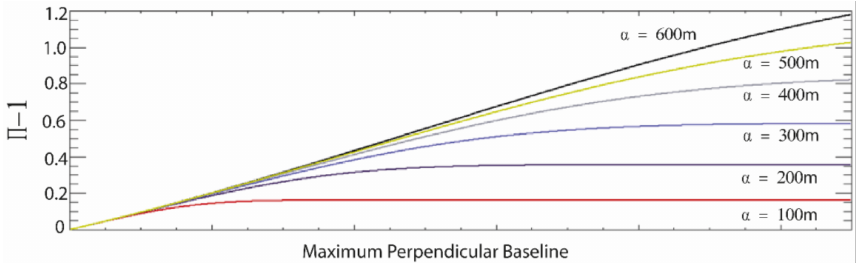
Figure 6. The plot of the term Π − 1 in Equation (23) vs. the maximum perpendicular baseline of the selected SB interferograms and various values of the standard deviation of the distribution of the perpendicular baseline of the whole possible InSAR data